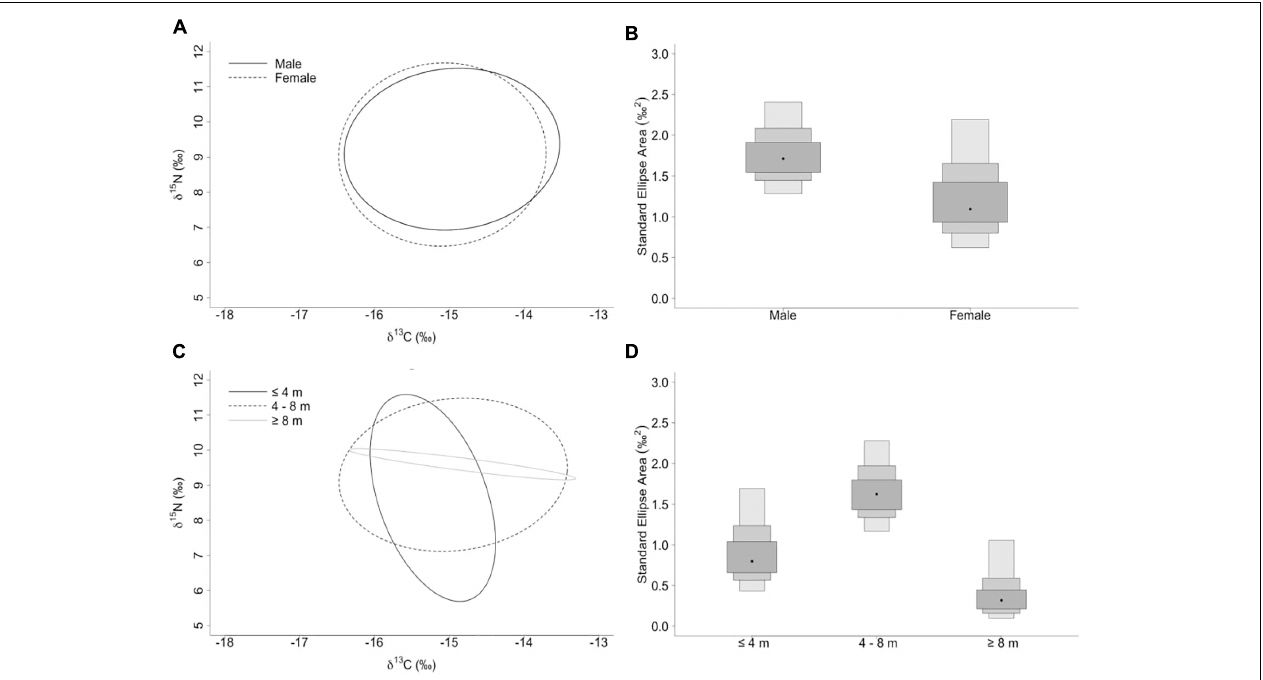
FIGURE 3 | (A,C) Sample size-corrected standard ellipse area (SEAc) calculated from δ 13 C and δ 15 N values of whale sharks separated by sex and size-class. (B,D) Bayesian estimates of the standard ellipse area (SEAb). Shaded ellipse area plots represent 50, 75, and 95% credible intervals with SEAb mode indicated by a black